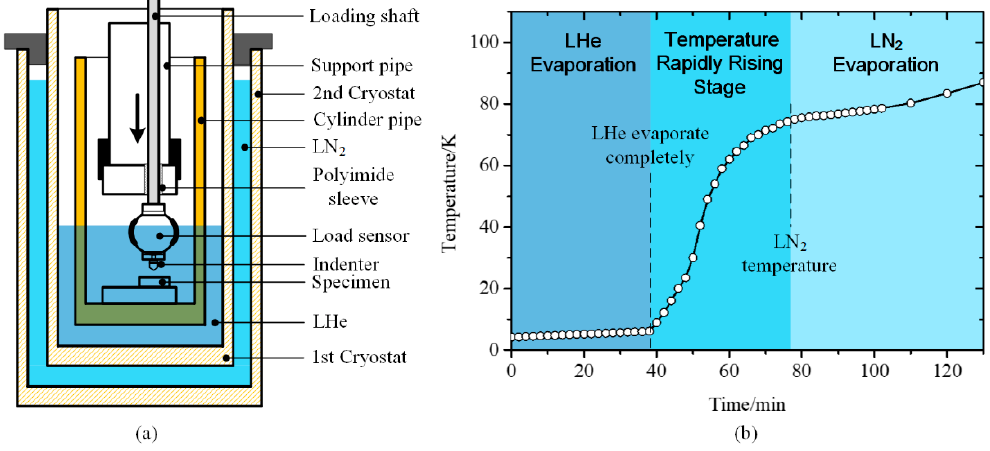
Figure 7. ( a ) Schematic diagram of 4.2 K indentation device. ( b ) Realization of temperature variation of specimen [47]. LHe = liquid helium.